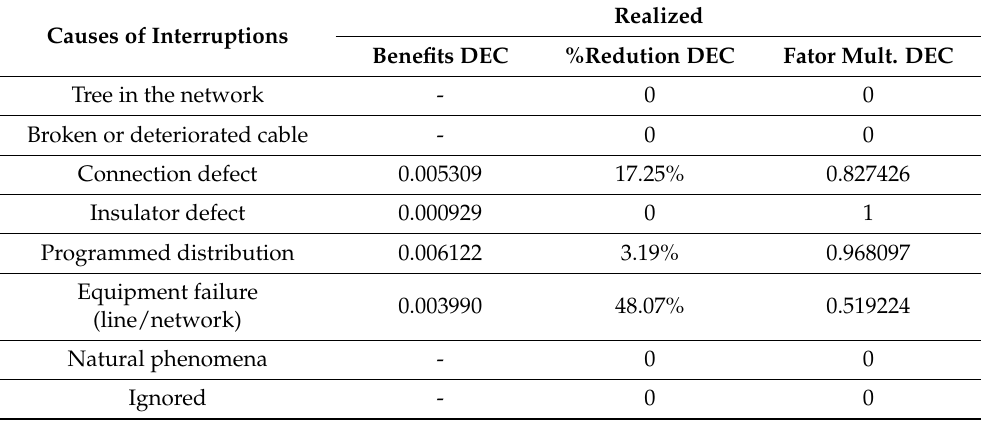
Table 2. Calculated benefits of